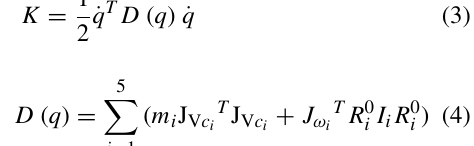
Fig. 3. Numbering adjacent joints and bodies to obtain D-H param- eters